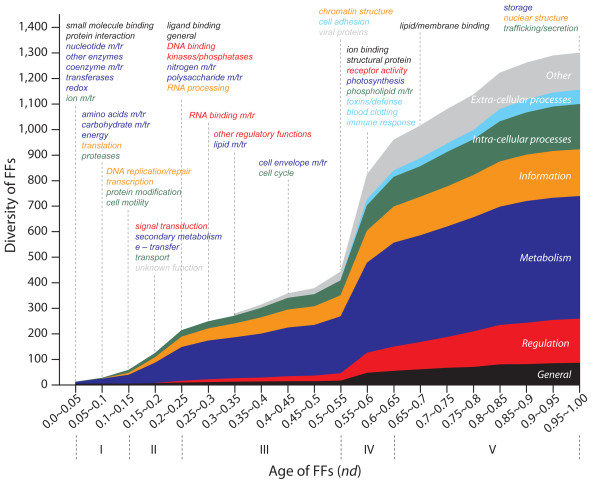
Emergence and evolution of molecular functions along the timeline. The cumulative frequency distribution plot illustrates the accumulation of FFs associated with the seven major functional categories of SUPERFAMILY. Dotted lines indicate the first appearance of FFs associated with one of the 49 minor functional categories.